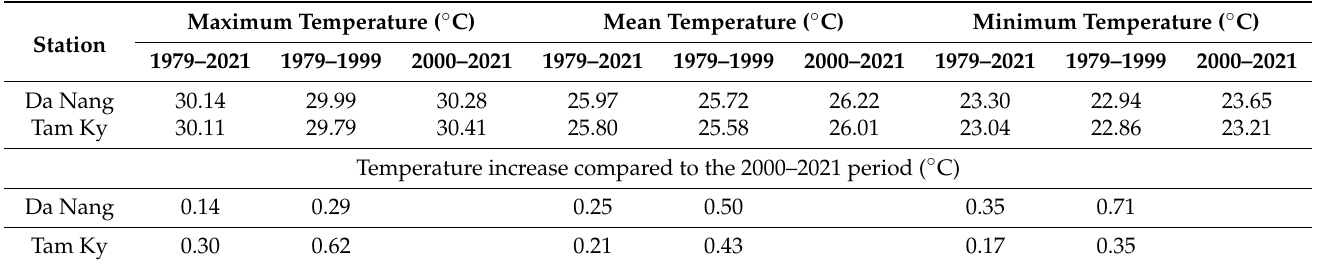
Table 5. The average temperature for different periods in Da Nang and Tam Ky meteorological